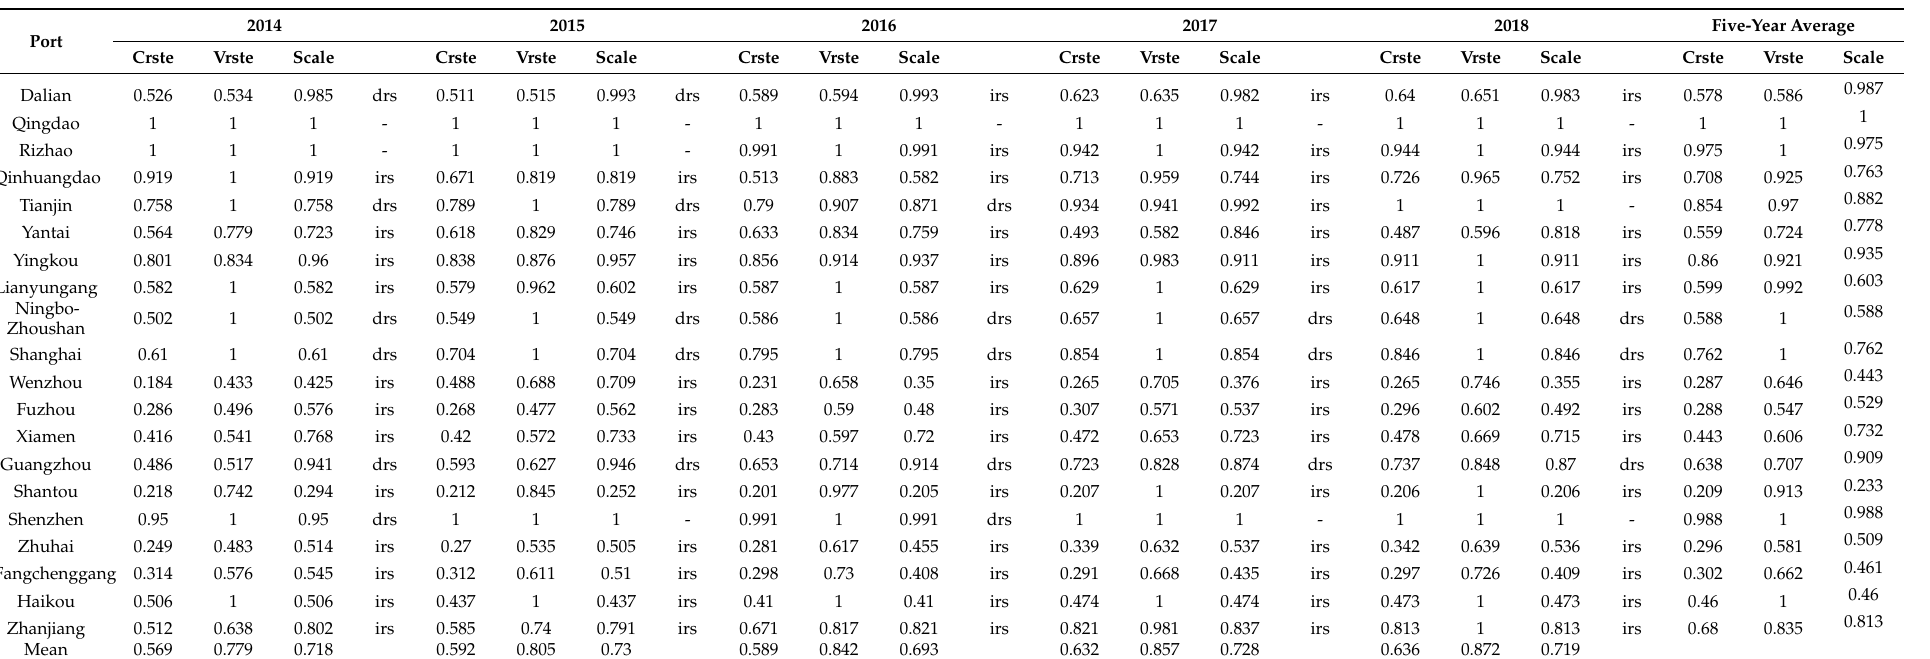
Table 4. The efficiency value of China’s coastal ports in stage III